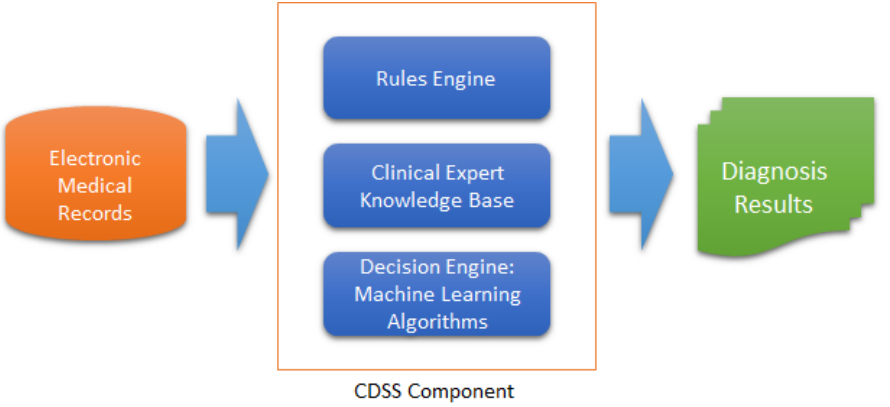
Figure 1. Machine learning is an integral part of the clinical decision support